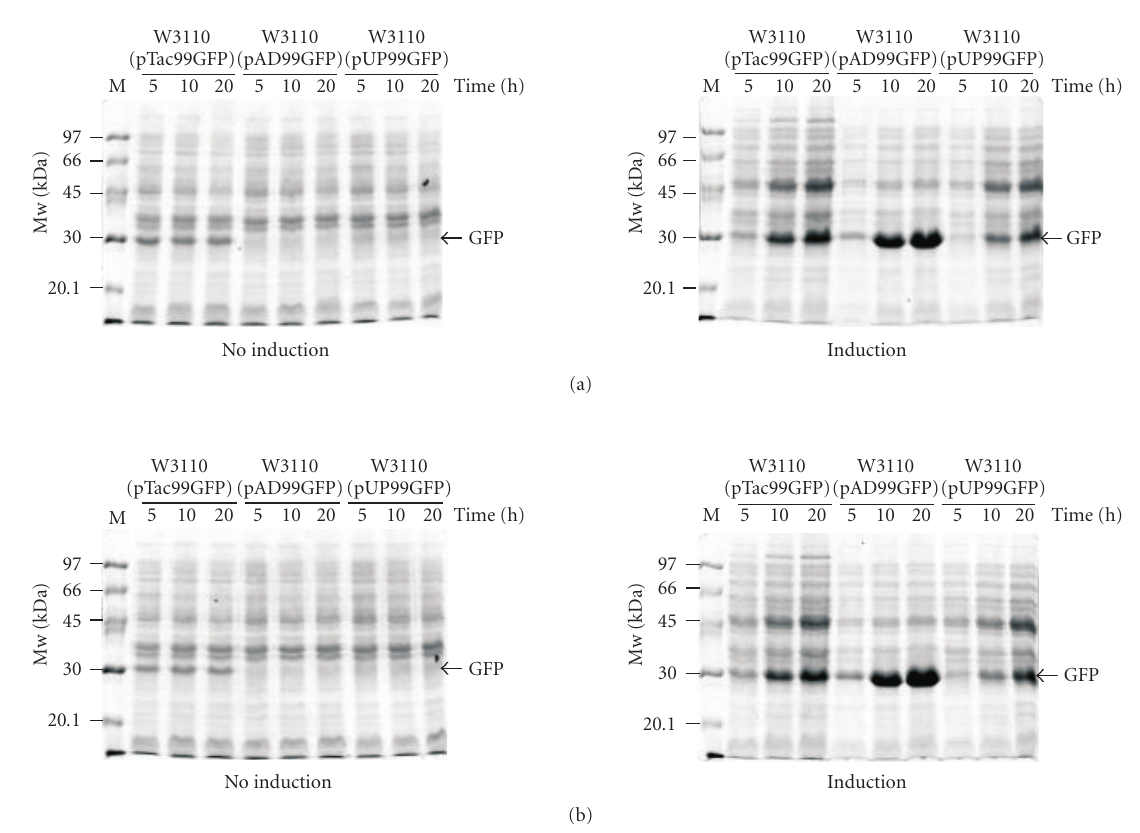
Figure 5: The e ff ect of the recombinant protein production by oleic acid-inducible promoter in recombinant E. coli W3110. The cells are induced by exchanging medium supplemented with glucose into the one with oleic acid at the OD 600 of 0.7 (a) or 1.2 (b). For the control, cells harboring the plasmid containing tac promoter were added with 1mM IPTG at the same values of OD 600 in the defined medium supplemented with glucose. After induction by IPTG or oleic acid, cells were further cultured for 5, 10, 20 hours, and harvested for 12% (w/v) SDS-PAGE. The arrows indicate the green fluorescent protein (GFP; 26.9 kDa). Size markers (in kDa) are also indicated.